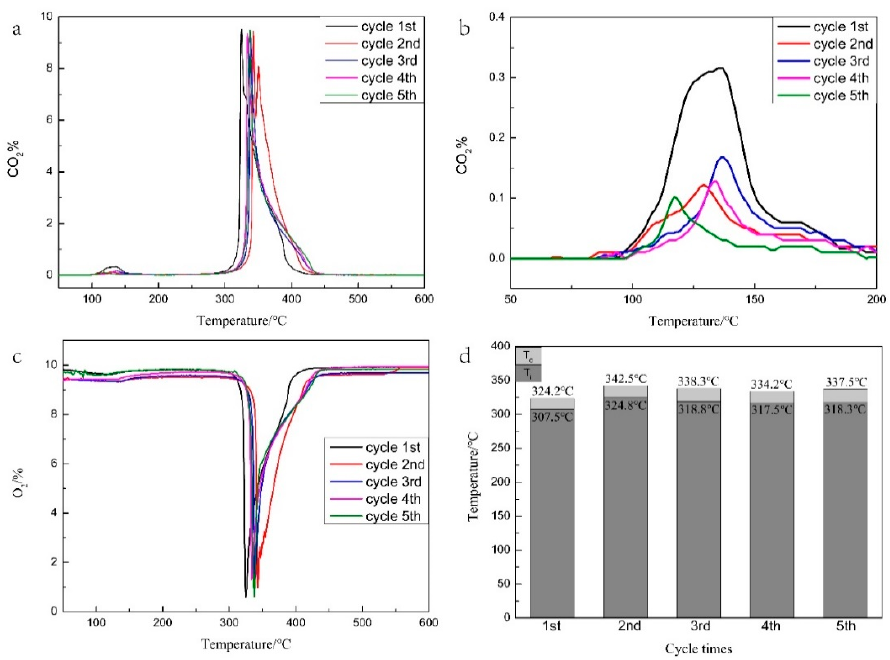
Figure 8. Catalyst K/ZC ( a,b ) CO 2 % vs. temperature ( c ) O 2 % vs. temperature ( d ) the ignition temperature (T i ) and the temperature of the maximum oxidation rate (T o ) vs. catalytic cycle times.